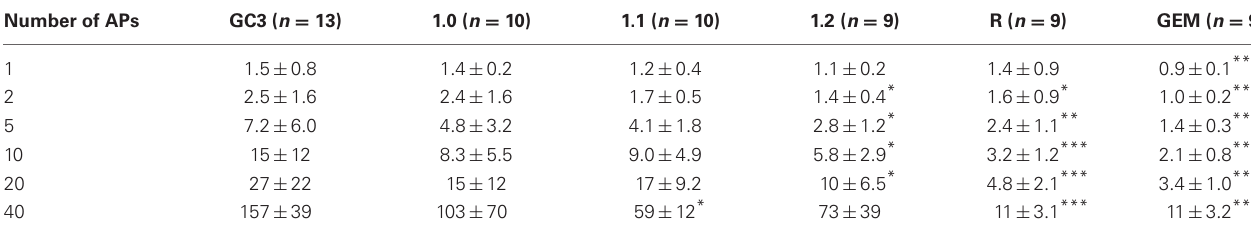
Table 3 | SNR of GCaMP3 and GECOs in cortical layer 2/3 pyramidal cells. Number of